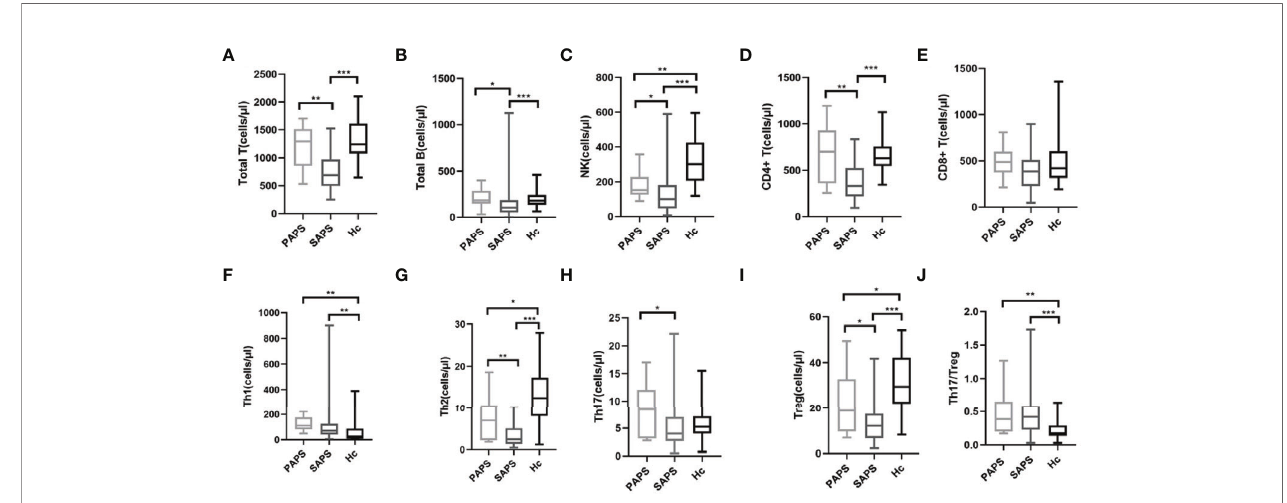
FIGURE 2 | Comparison of lymphocyte absolute values and CD4+ T cell subsets in PAPS group (n=12), SAPS group (n=55) and healthy control group (n=40) ( ∗ p < 0.05, ∗∗ p < 0.01, and ∗∗∗ p < 0.001). Compared with the healthy control group, the differences in Treg cell subset and Th17/Treg value were statistically signi fi cant, regardless of PAPS group or SAPS group. (A – E) represent the differences in the absolute value of lymphocyte in three groups (corresponding to Total T, Total B, NK, CD4+T, CD8+T,respectively). (F – J) means the differences in absolute value of Th subsets of three groups (corresponding to Th1, Th2, Th17, Treg,